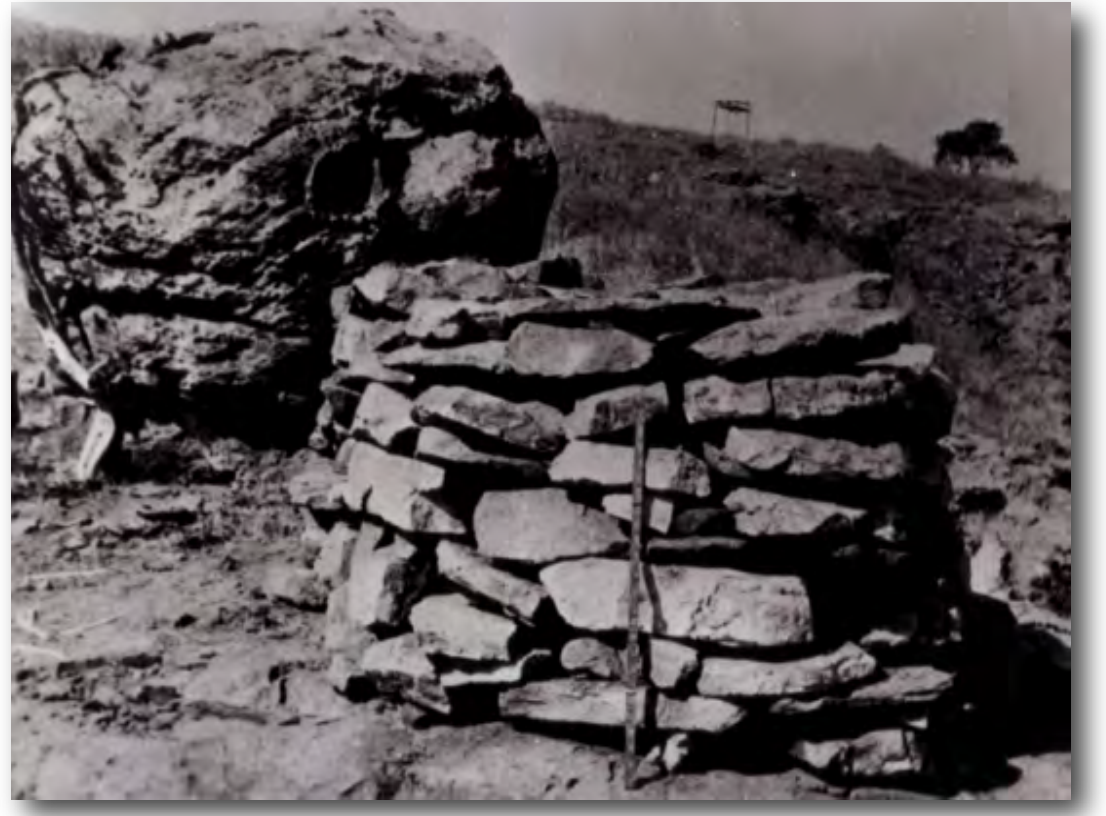
Figure 2. Free-standing stonewall above the western (southern) ascent to the summit of Mapungubwe Hill (Fouché 1937:Plate VIII,